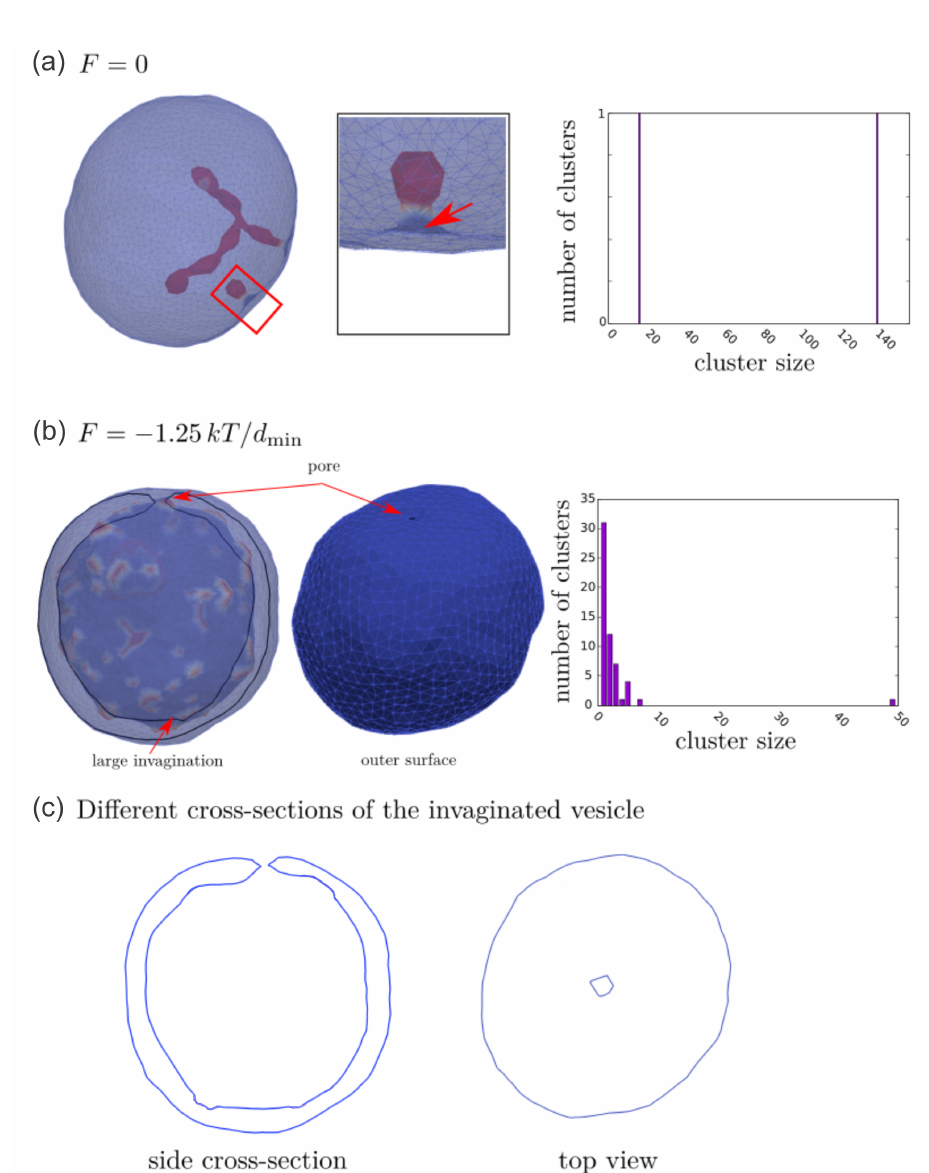
Figure 14. Inset ( a ): The Monte-Carlo simulation of the transformation of the RBC membrane induced by mobile membrane nanodomains with negative local intrinsic curvature c = − 1d − 1 absence of the active force of NMIIA nanodomains. Concentration of membrane nanodomains is p = 5%. Semitransparent visualization of the triangulated membrane surface is used in order to uncover its interior shape. Red arrow in the middle enlargement points to the neck area in which there is a lack of nanodomains. In the corresponding cluster-size distributions, the y -axis represents the ensemble averaged number of nanodomain clusters of each size, while the x -axis is the size of the cluster of inclusions. Other parameters: local bending stiffness of lipid bilayer κ = 25kT and direct interaction parameter w = 1.25kT. In the inset ( b ), there are results for the same parameters with additional active force of NMIIA nanodomains towards the cell interior. Inset ( c ) shows different views of the vesicle from ( b ) (side cross-section and top view). Adapted with permission from